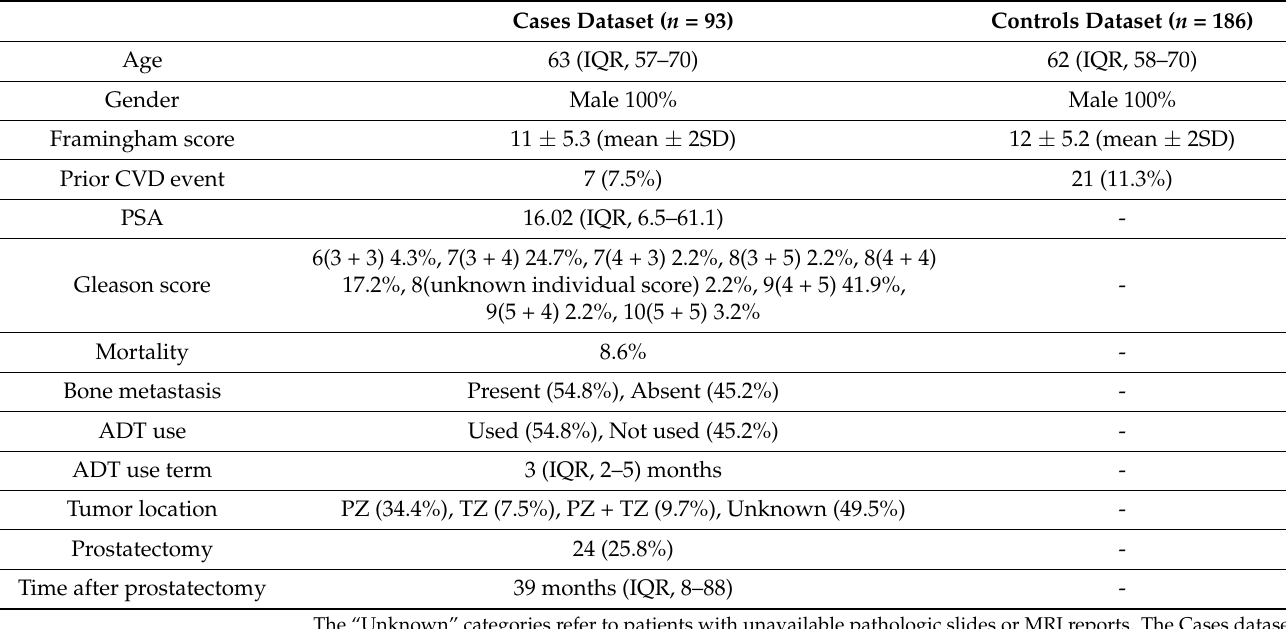
Table 1. Patient characteristics of the